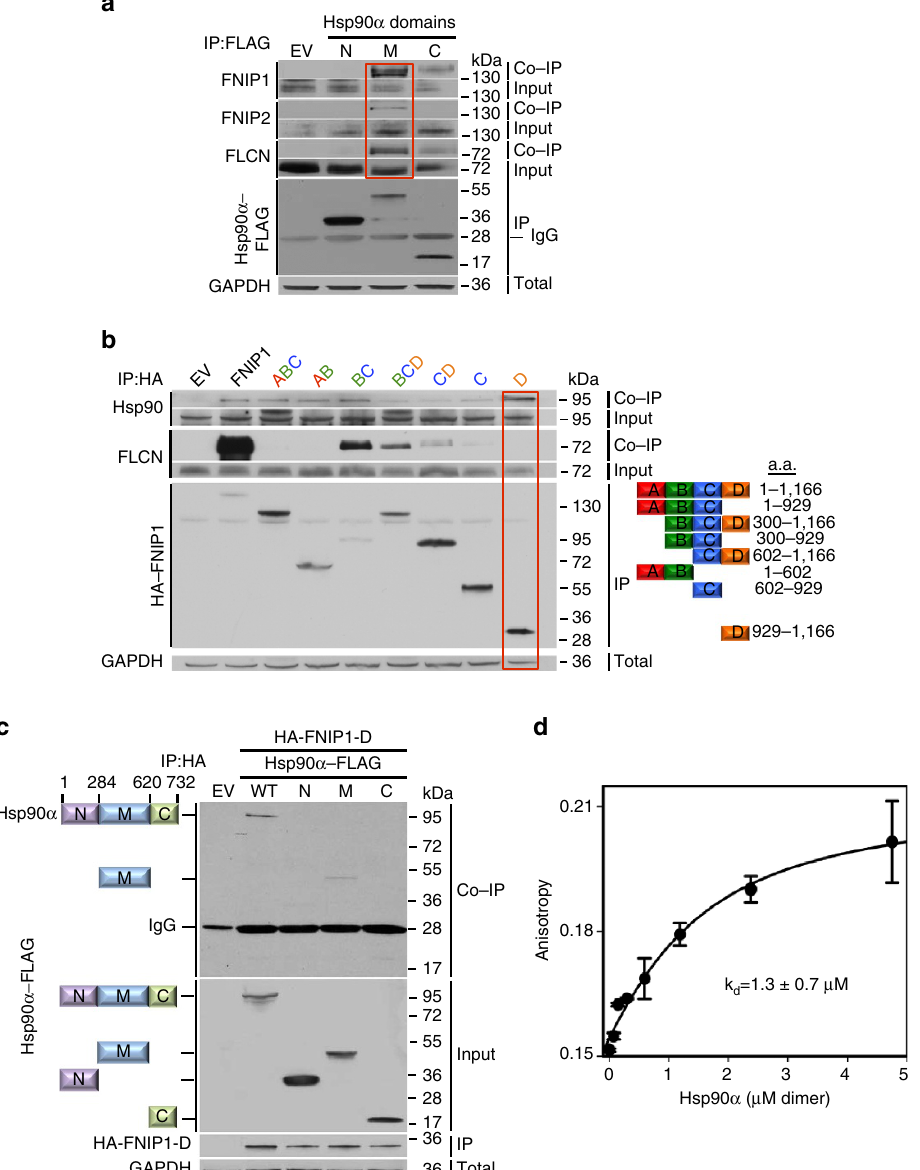
Figure 3 | FNIPs directly bind to Hsp90 M- and C-domains. ( a ) FLAG-tagged Hsp90 a -N-, M-, and C-domains were transiently expressed and immunoprecipitated from HEK293 cells. Co-IP of endogenous FLCN and FNIPs were assessed by immunoblotting. Empty vector (EV) was used as a control. ( b ) HA-tagged FNIP1 domains were transiently expressed and isolated from HEK293 cells. Co-IP of endogenous FLCN and Hsp90 were assessed by immunoblotting. Empty vector (EV) was used as a control. ( c ) FLAG-tagged Hsp90 a domains were transiently co-expressed with HA-tagged FNIP1-D in HEK293 cells. HA–FNIP1-D was immunoprecipitated and Hsp90 a –FLAG co-IP was evaluated by immunoblotting. ( d ) Bacterially expressed and purified FNIP1-D and Hsp90 a binding affinity measured by fluorescence anisotropy. The error bars represent mean ± s.d. of three independent experiments. bacterially expressed and purified fragment D (FNIP1-D–His 6 ), (Supplementary Fig. 2b,c) and examined its affinity for binding to Hsp90 a in vitro by fluorescently labelling FNIP1-D–His 6 with Texas Red Maleimide, and measured the K d by fluorescence anisotropy (Fig. 2j). Our bacterially expressed and purified HSP90 a had ATPase activity. The titration fit to a single-site binding equation with a K d of 1.3 ± 0.7 m M (Fig. 3d). This K d was unaffected by the presence, absence or identity of adenosine nucleotide bound to the protein (Supplementary Fig. 2d). Taken together, our findings suggest that FNIPs behave as co- chaperones of Hsp90 and they are involved in loading of FLCN to Hsp90. NATURE COMMUNICATIONS|7:12037|DOI: 10.1038/ncomms12037|www.nature.com/naturecommunications